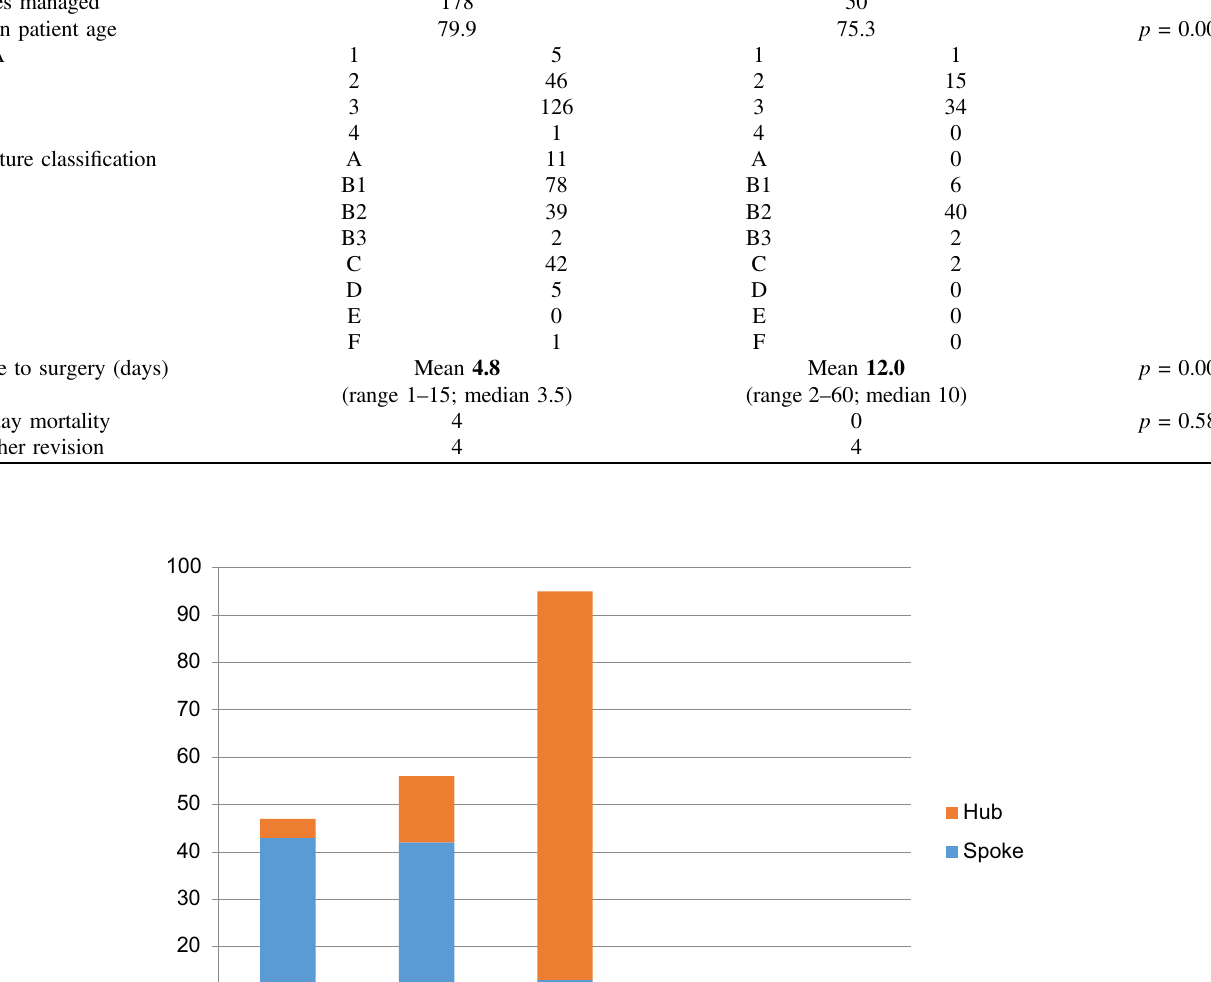
Table 1. Comparison between patients treated inhouse (Spoke) and those transferred to the Hub.